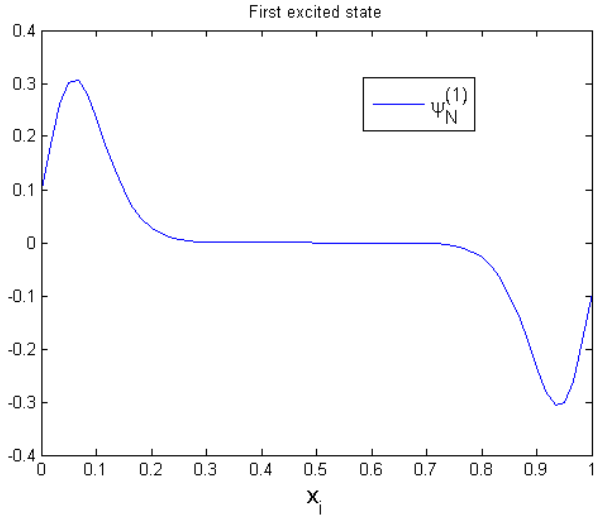
Figure 2: First excited state of h CW N = 60 , J = 1 and B = 1 / 2 . The grid points on the horizontal axis are indicated by = i / N for i = 0,..., x i